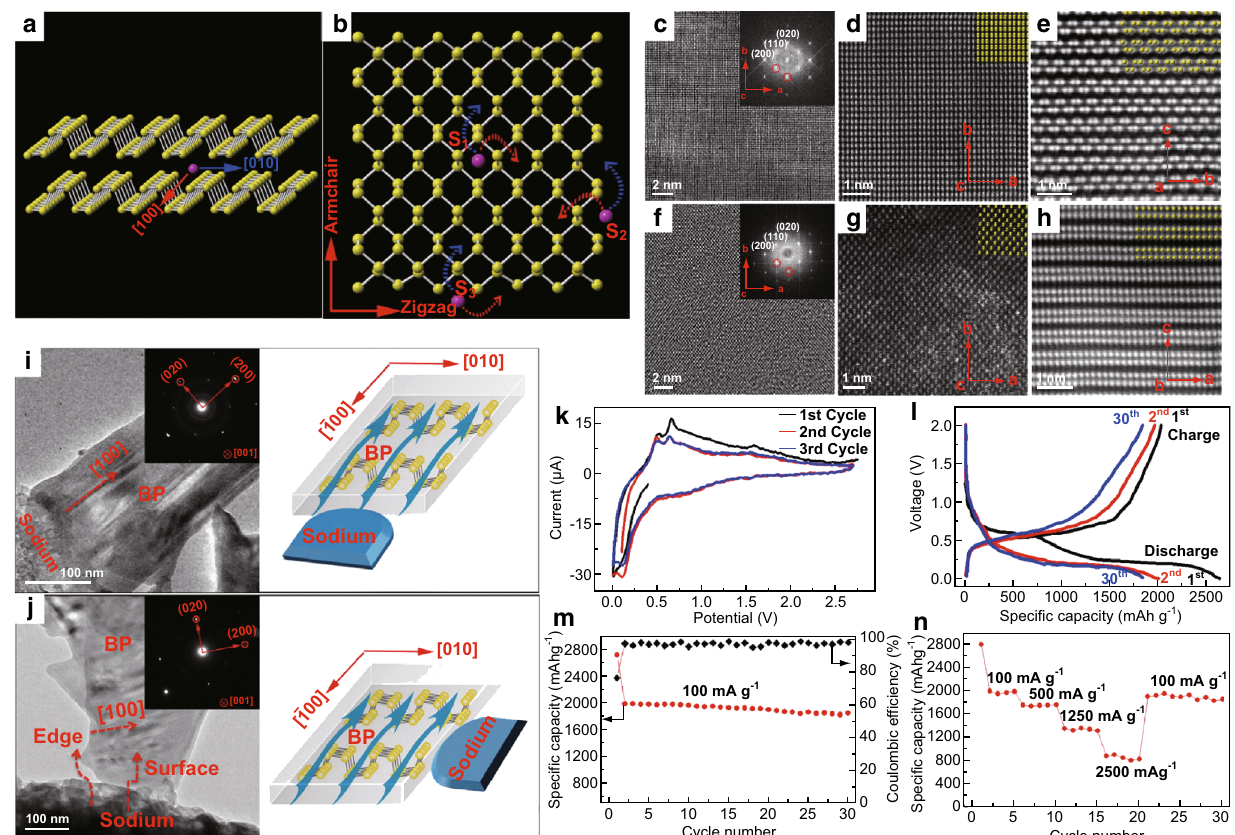
Fig. 9 Structural characterization and electrochemical performance analysis of phosphorene electrode material in SIB: a Schematic showing the movement of Na ? ion between phosphorene layers. b Energetics dictated transport of Na ? ions in the interstices of phosphorene lattice. c , f HRTEM images along the [001] direction of few-layer phosphorene and single-layer phosphorene, respectively, with FFTs shown in the inset of each. d , g Atomic-scale high-angle annular dark field image (HAADF) along the [001] direction of few-layer phosphorene and single-layer phosphorene, respectively, with atomic orientations in inset (in yellow). e , h HAADF of few-layer phosphorene along the [100] and [010] directions, respectively, with the corresponding atomic orientations in the inset (in yellow). i , j TEM image and schematic of the contact interface of Na ? ion normal to the [100] direction and along the [100] direction, respectively. The SAED patterns of the few-layered phosphorene are shown in the inset of both. k CV of the first three cycles of the phosphorene electrode for the half cell at a scan rate of 0.005 mV s - 1 . l GCD profiles of the 1st, 2nd, and 30th cycle for the phosphorene electrode in the half cell. m Capacity retention and coulombic efficiency of the phosphorene electrode running at a current density of 100 mA g - 1 . n Rate capability of the phosphorene anode [163]. Copyright 2016 American Chemical Society. (Color figure